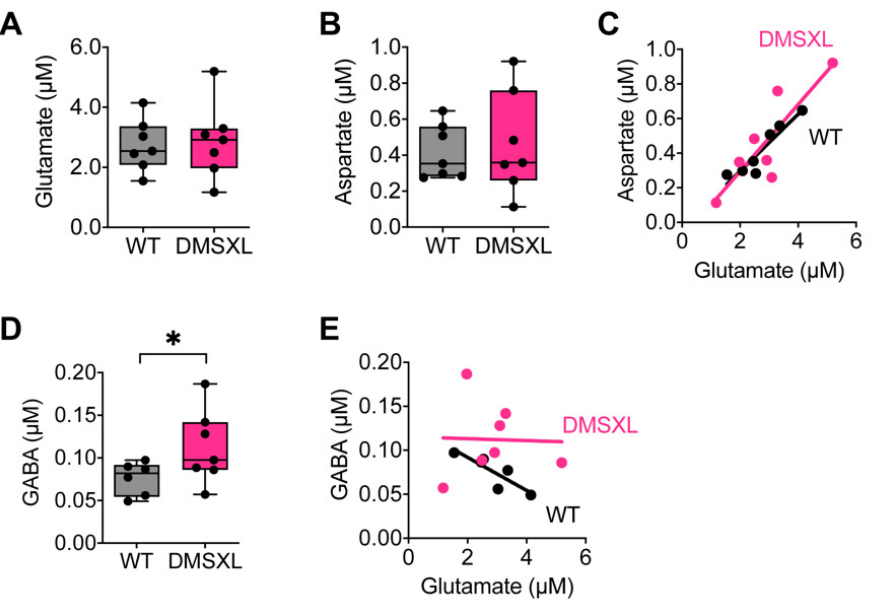
Figure 2. Levels of neurotransmitters in mouse dorsal hippocampus. Extracellular levels of glutamate ( A ) and aspartate ( B ) in DMSXL ( n = 6) and WT mice ( n = 7) at 1–2 months of age. ( C ) Correlation between the levels of excitatory glutamate and aspartate in DMSXL mice (R 2 = 0.73; * p = 0.015) and WT controls (R 2 = 0.88, ** p = 0.0019). ( D ) Extracellular levels of GABA in DMSXL and WT mice. * p = 0.040. ( E ) Correlation between the levels of inhibitory GABA and excitatory glutamate in DMSXL (R 2 = 0.001; p = 0.95) and WT mice (R 2 = 0.74; * p = 0.027).